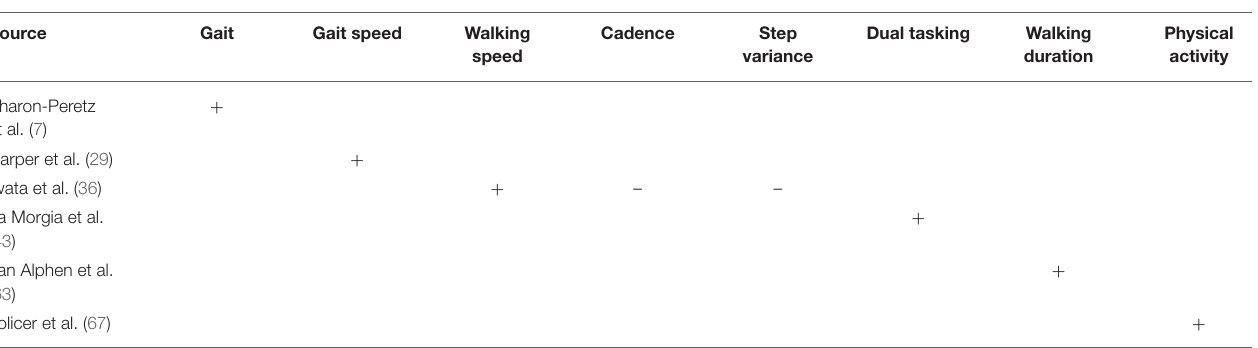
TABLE 5 | Specific outcome measures of gait and walking activity reported by included